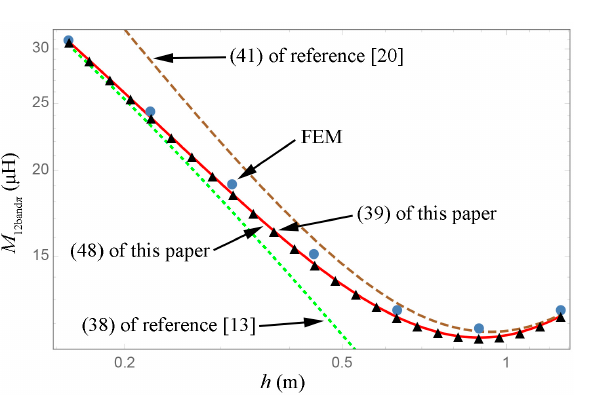
M π ) of closely wound tape 12band